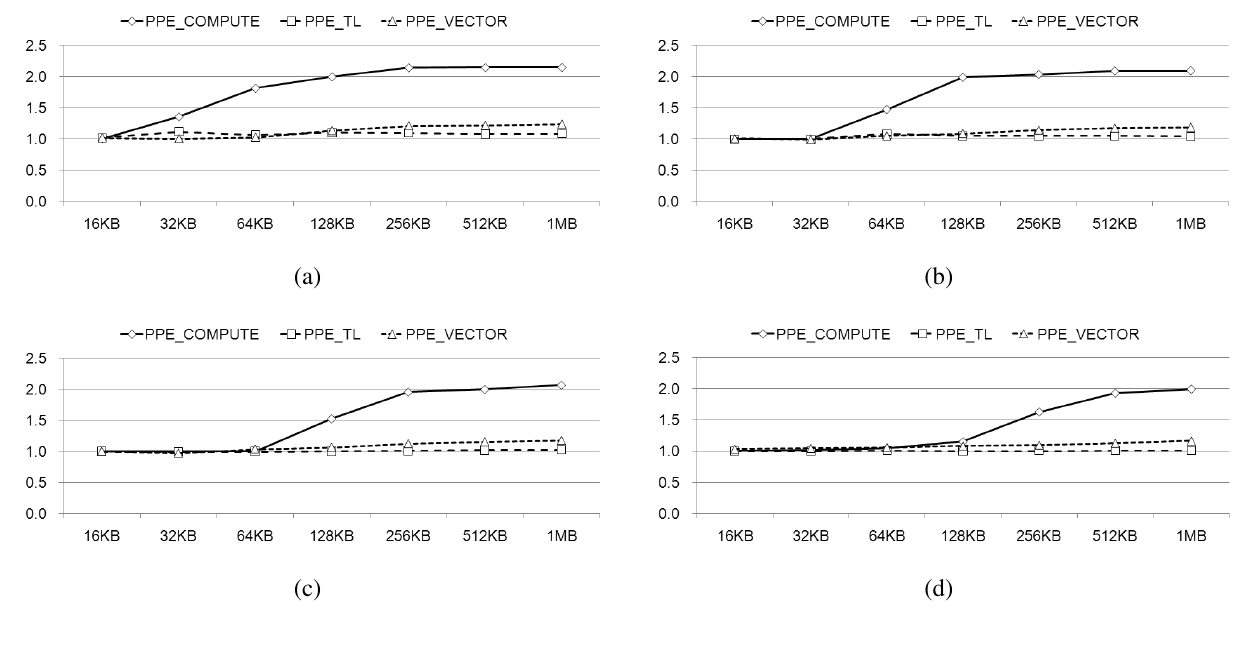
Figure 16. Speed-up of the algorithms compared with the result of having factor “1” when varying coefficient matrix size; ( a ) 64 × 64; ( b ) 128 × 128; ( c ) 256 × 256; and ( d ) 512 ×